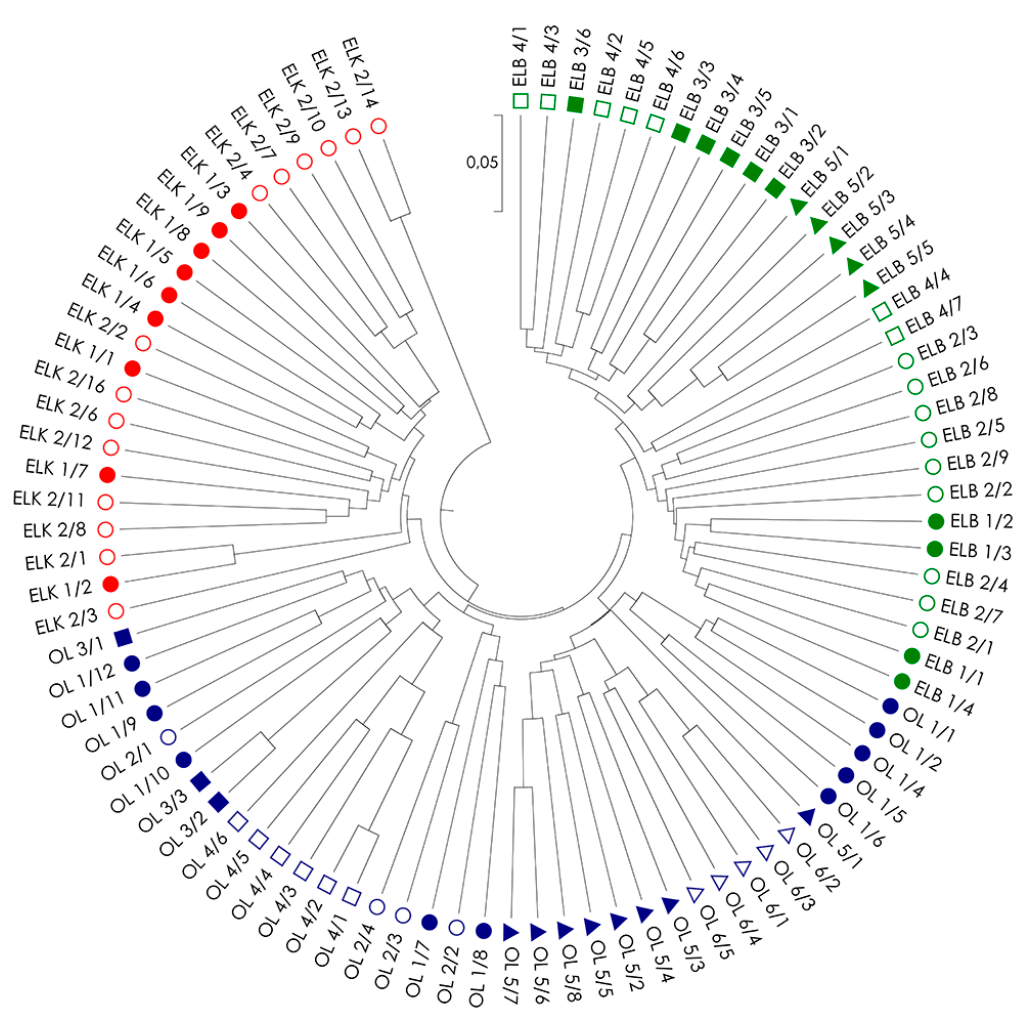
Figure 2. UPGMA (unweighted pair group method with arithmetic mean) dendrogram of genetic distance between 91 genotypes of S. purpurea based on a combined analysis of all used marker systems (AFLP, RAPD and ISSR). The analyzed locations are marked in different colors .